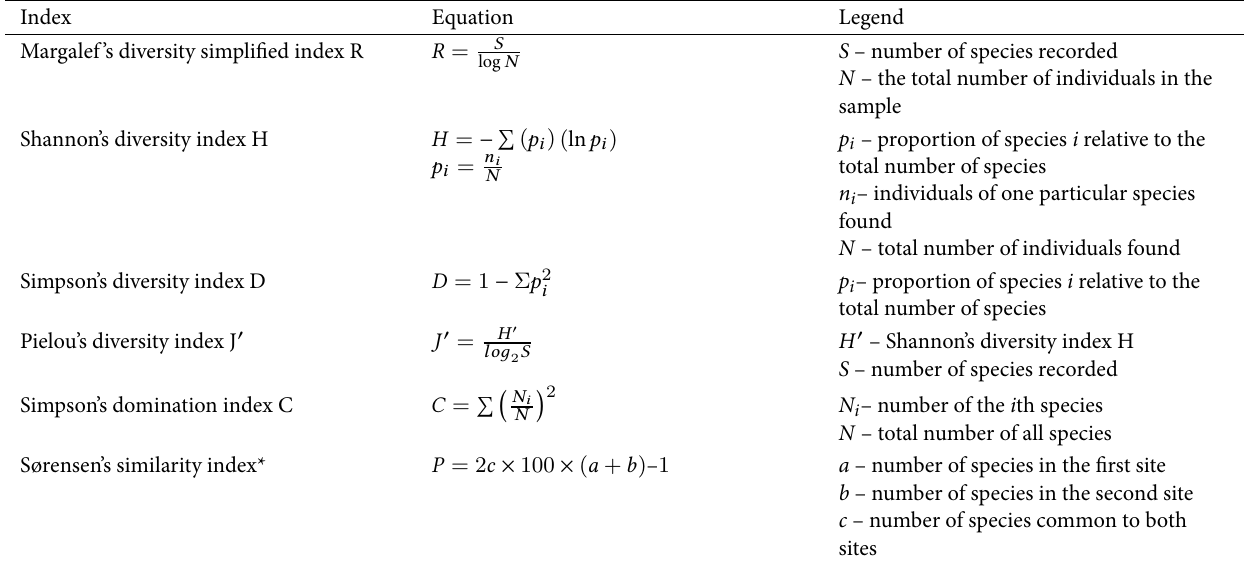
Table 2 Ecological indices used in the